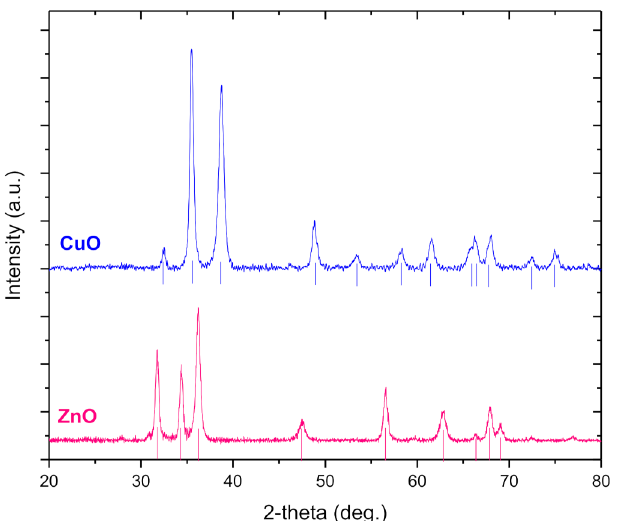
Figure 1. XRD patterns of CuO and ZnO NPs; straight lines indicate the match to the reference patterns of CuO and